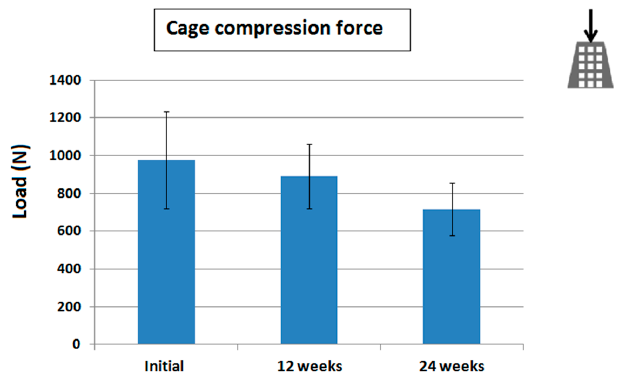
Figure 1. The three-dimensional (3D) printed cage degradation test. Compressive results showed averaged maximal compressive loads of 977, 889, and 715 N immediately after, at 12 and 24 weeks after immersion in phosphate buffer solution (PBS), respectively. These results evidenced the cage degradation. Photography on right upper corner represented the direction of the compression test.